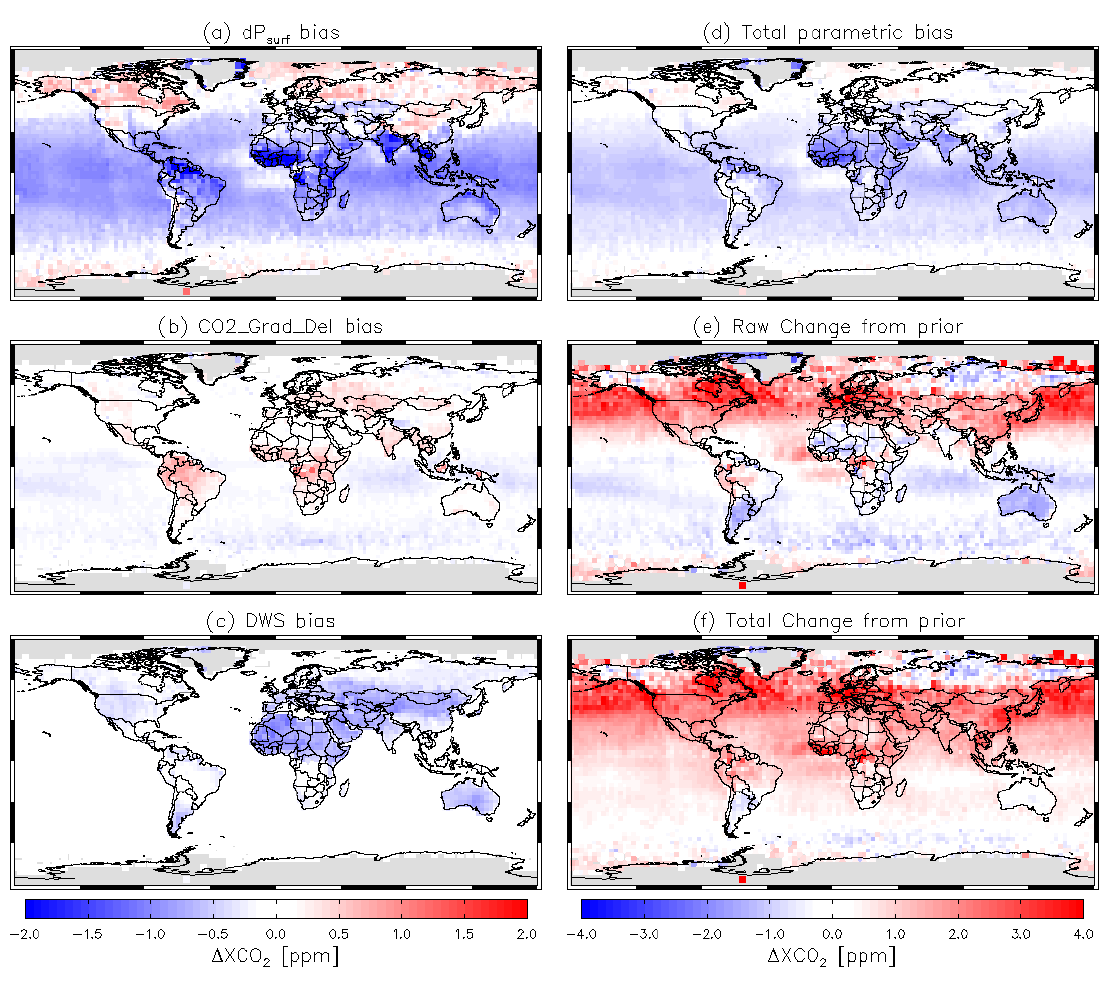
Figure 17. Annual mean biases and changes from the prior for all quality-flag “good” soundings from September 2014 through Septem- ber 2017. (a–c) Parametric biases for d P , co2_grad_del, and DWS. (d) Sum of the parametric bias terms – note the color scale change. (e) Departure of the raw retrieved X CO , including the global scaling correction, from the prior, X CO 2 − X the bias-corrected X CO from the prior, X CO CO 2 , ap . 2 2 , bc